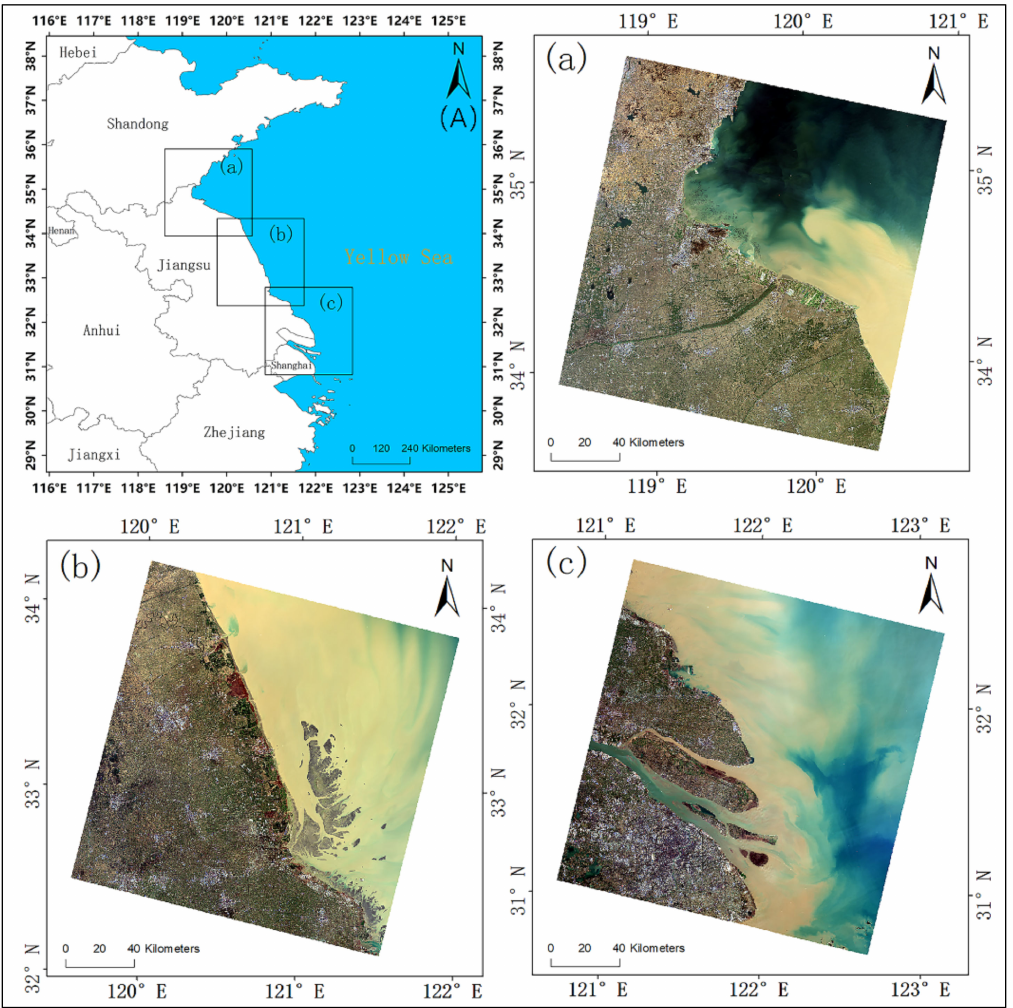
Figure 1. Schematic diagram of the study area: (A) study area and image coverage location map ( a ) northern Jiangsu coast; ( b ) central Jiangsu coast; ( c ) southern Jiangsu coast. All images correspond to the data in Table 1, while the path and row numbers are 120036, 119037 and